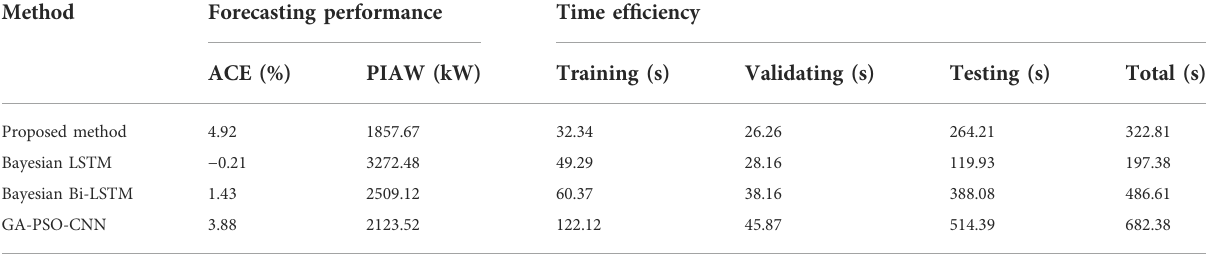
TABLE 2 Performance comparison of different forecasting